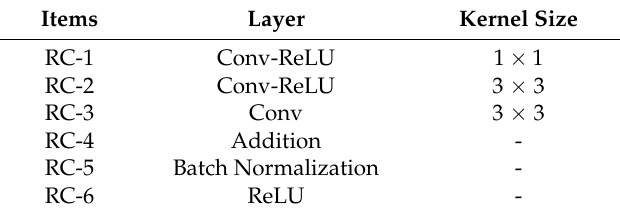
Figure 3. The structure of residual connected unit. Figure 2. The structure of residual connected unit. Table 1. The details of Residual connected Table 1. The details of Residual connected unit.